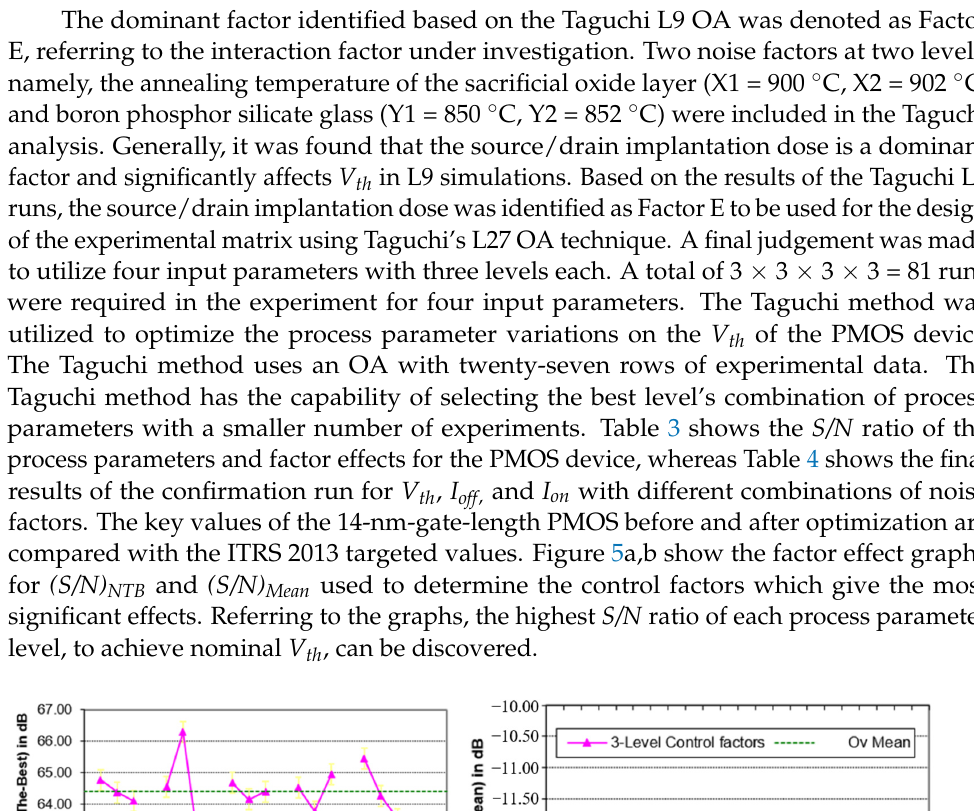
Table 3. S/N ratios of process parameters and factor effects for a PMOS device. Sym.